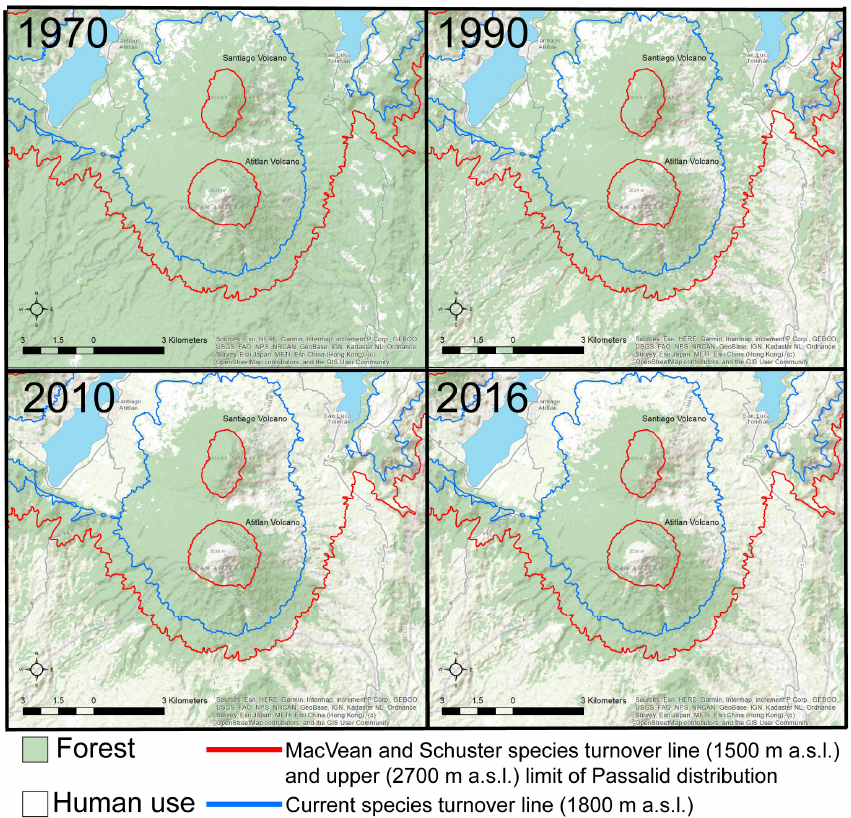
Figure 4. Changes in the forest coverage of the Atitlan volcano between 1970 and 2016. Forest coverage data were obtained from [39,40].